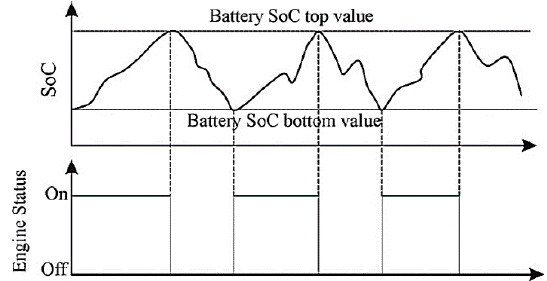
Figure 3. Illustration of thermostat CsT [26]. SoC : state of charge.